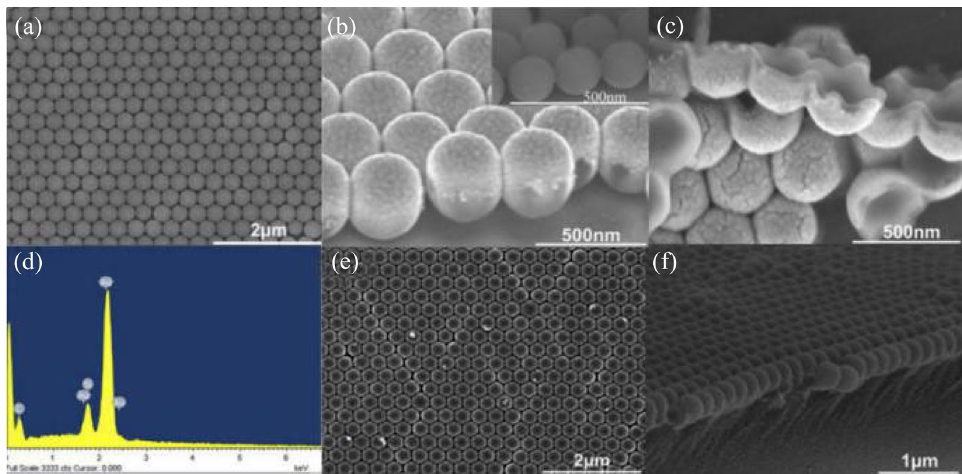
Figure 16 a Top view of SEM image of 2D PS colloidal crystal with gold nanoshell; b Cross-sectional view of SEM image of image a , (inset: SEM image of PS colloidal crystal); c SEM image of gold nanoshell after dissolving PS microspheres in methylene chloride; d EDS analysis of Au nanoshell;